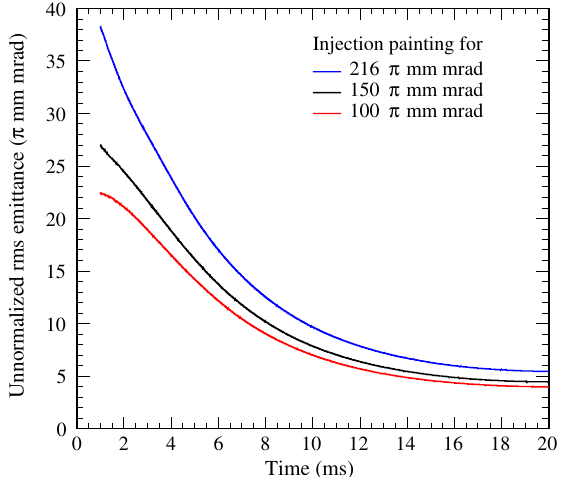
FIG. 2. Damping of the transverse rms horizontal emittance and dependence of the rms emittance at the top energy on the initial injection painting area as estimated in the numerical simulations. A smaller initial painting area gives a comparatively smaller emittance of the extracted